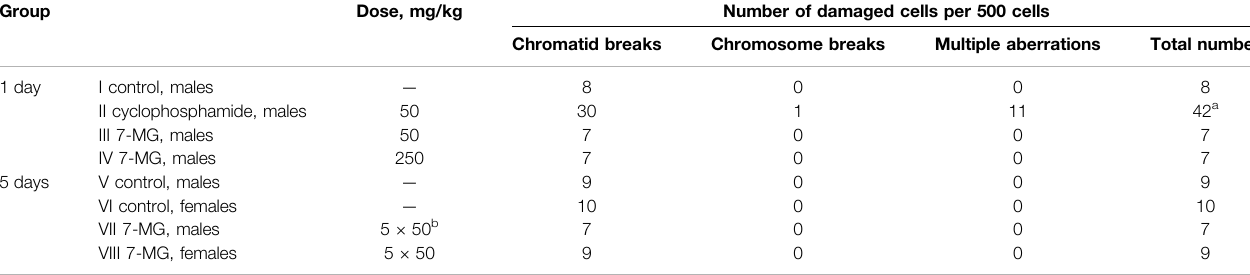
TABLE 3 | Study of the ability of 7-MG to induce chromosomal aberrations in C57BL/6 mice. Group Dose, mg/kg Number of damaged cells per 500 cells